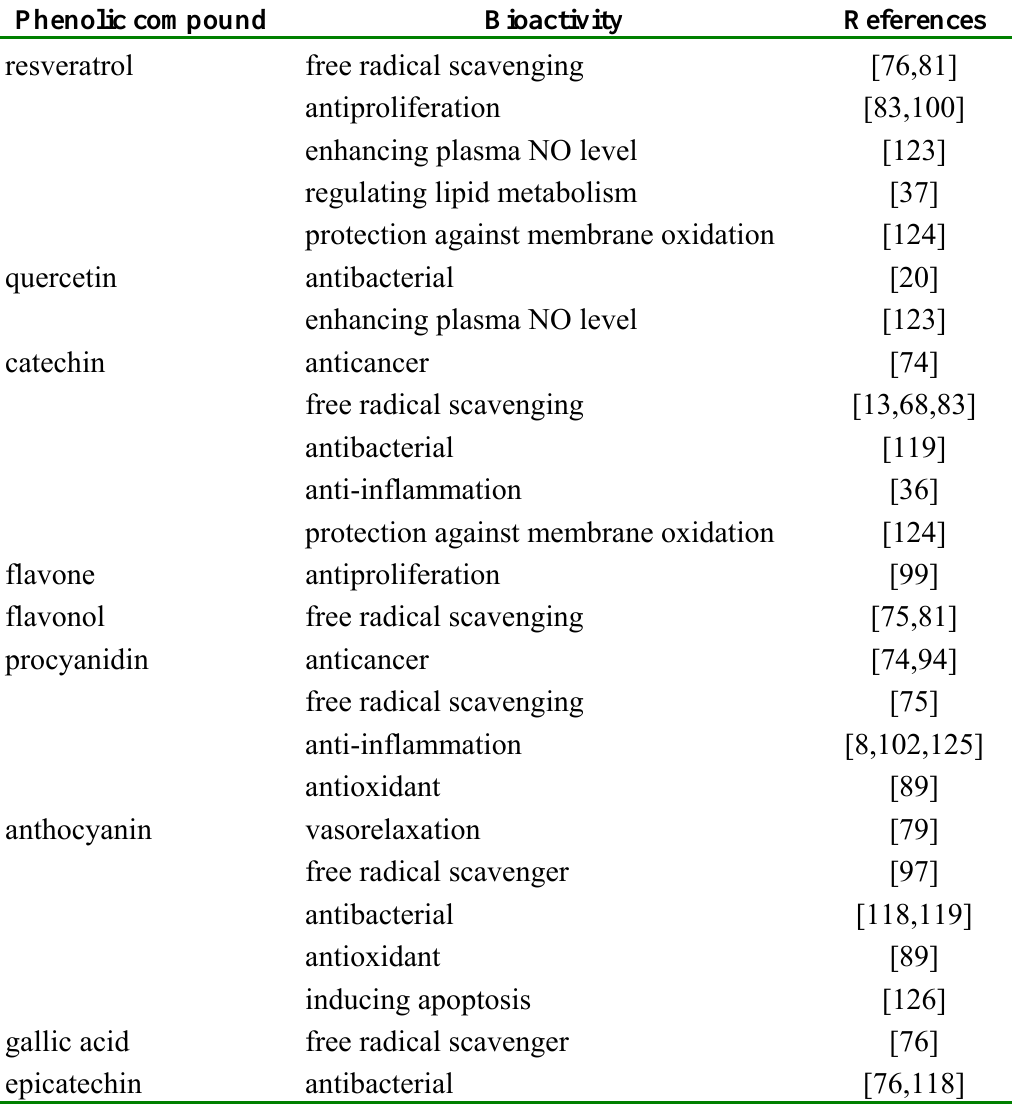
Table 5. Bioactivities of some phenolic compounds from